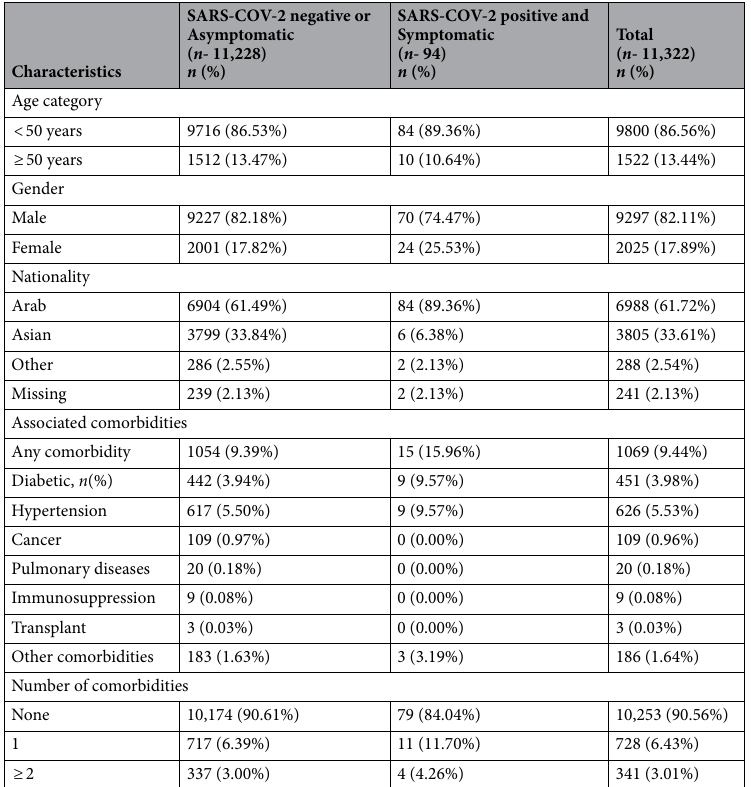
Table 2. Demographic and clinical characteristics of the study